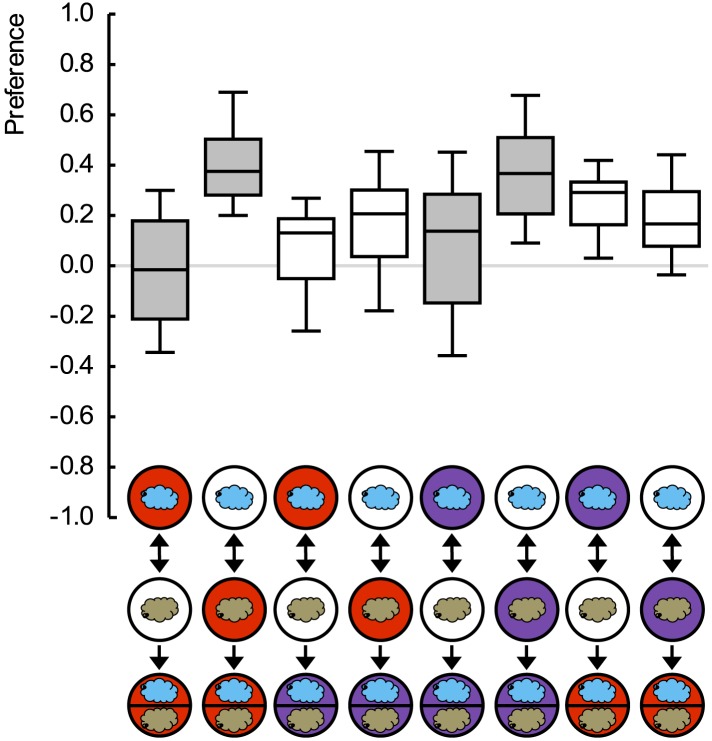
Preference scores for the reciprocally trained groups of Figure 2.Sample sizes: 25–32. Shaded boxes indicate differences between groups (p < 0.05/4, Mann–Whitney U-tests). For a detailed description of the sketches, see legend of Figure 1.